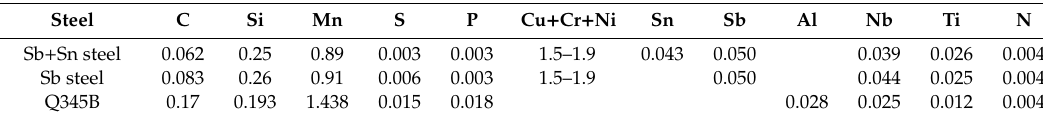
Table 1. Chemical composition of two experimental steels and Q345B (wt.%).